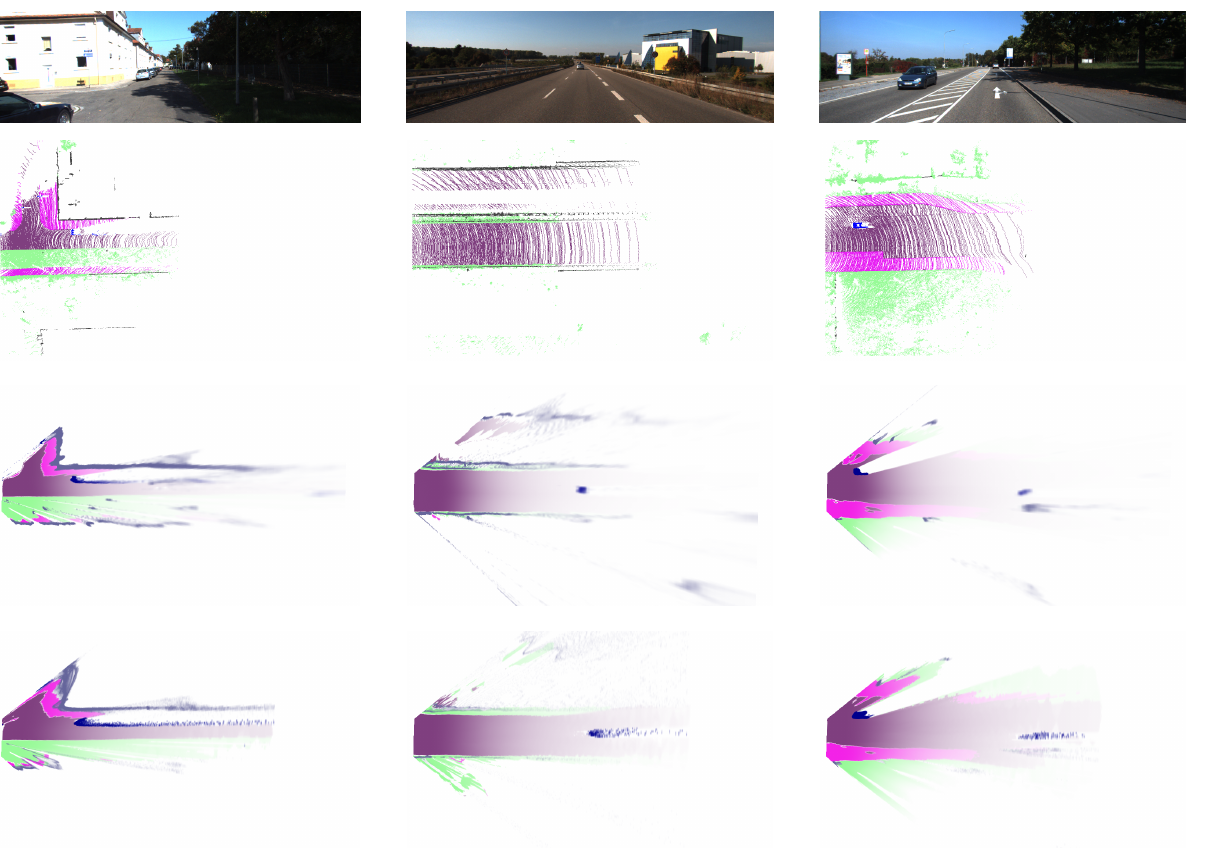
Figure 8. The resulting BBA for stereo and mono images. Each column corresponds to one frame in the Kitti odometry benchmark depicted in the image in the first row. The second row shows the ground truth, the third row shows the results for stereo vision, and the last row shows the results for